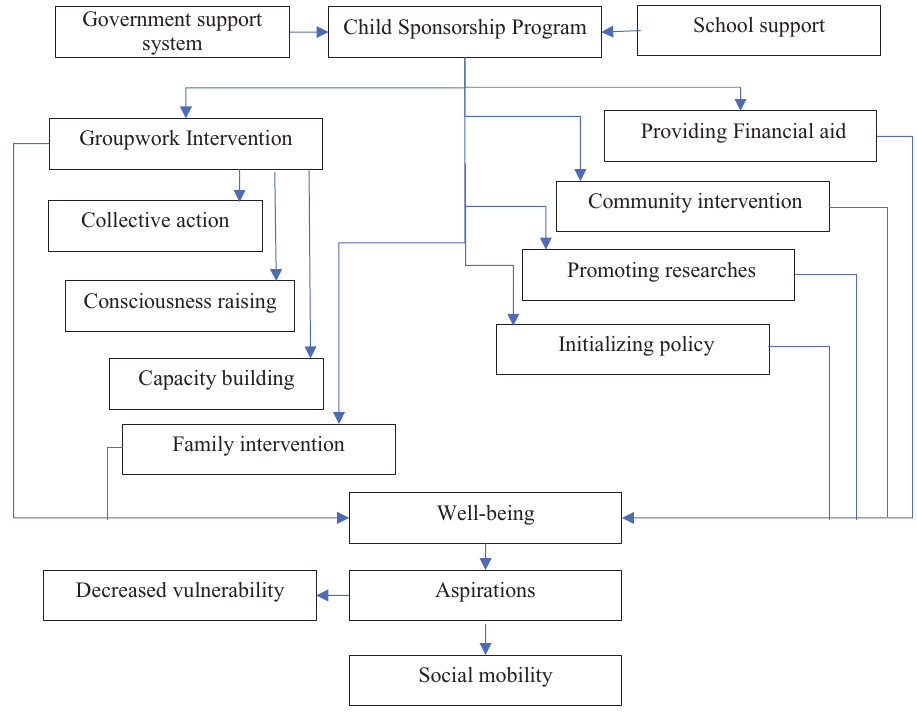
Figure 3. A conceptual framework for child sponsoring